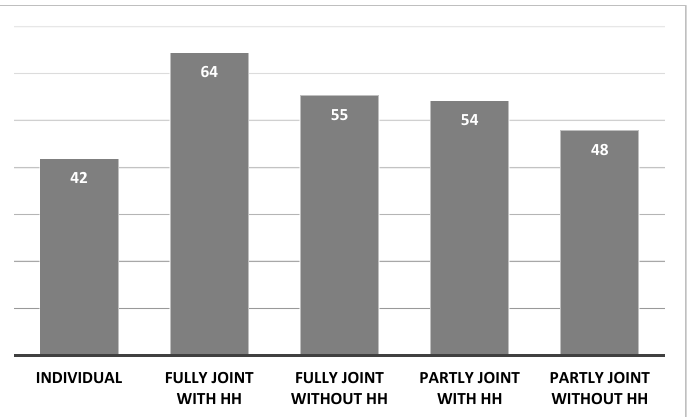
Figure 1. Share of joint tours (%) by car in